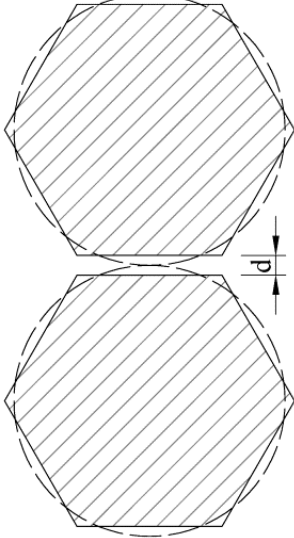
Figure 12. Quantified inter-strand distance.